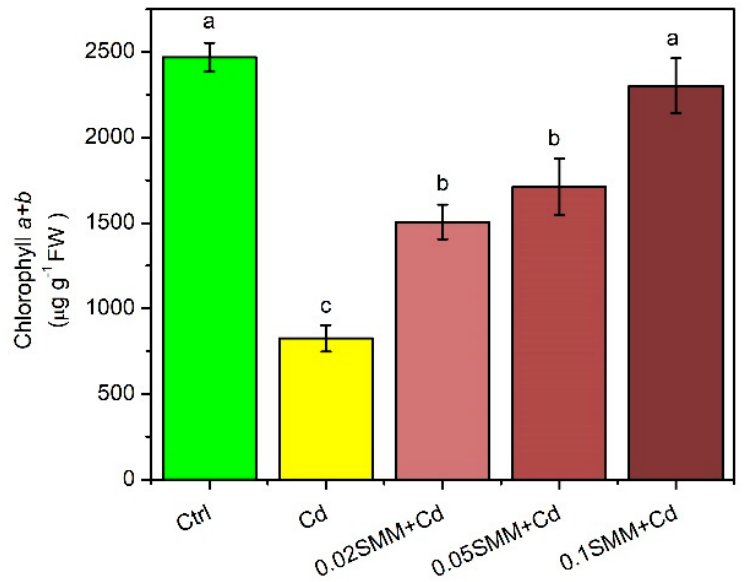
Figure 2. Total Chl concentration of the youngest fully developed leaves of Szarvasi-1 energy grass primed with 0.02, 0.05 and 0.1 mM SMM and exposed to 0.01 mM Cd expressed on a fresh weight (FW) basis. Error bars represent SD values. To compare the differences, one-way ANOVA was performed on each dataset combined with Tukey–Kramer post hoc test on the treatments ( p < 0.05). Different lowercase letters indicate significantly different groups.